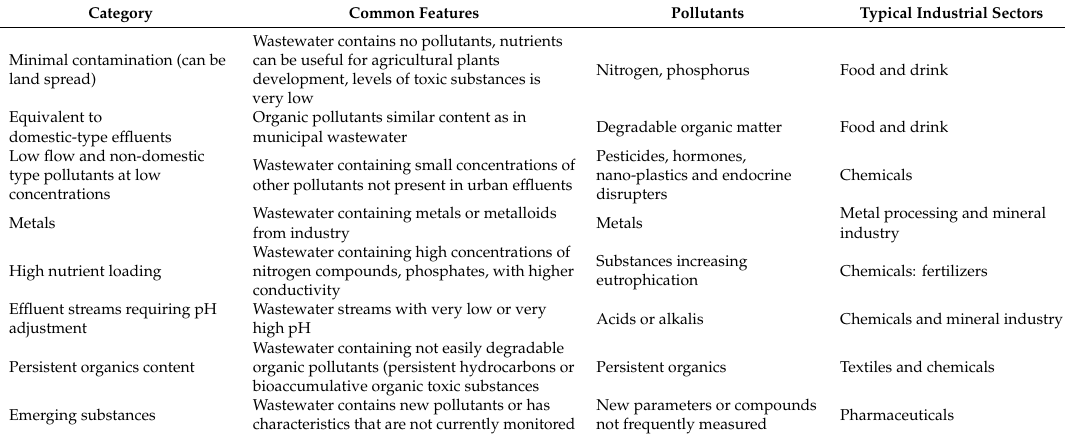
Table 1. Industrial wastewater types depending on the industrial sectors [7], edited by the authors. Category Common Features Pollutants Typical Industrial